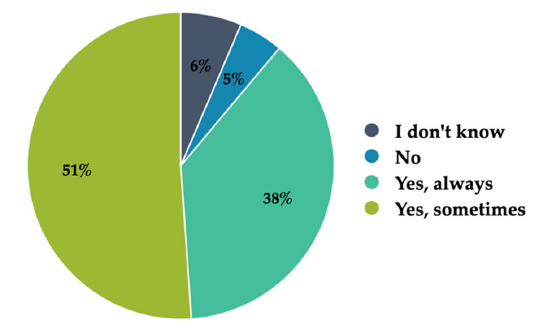
Figure 4. Do you think the Internet is indispensable in your life?